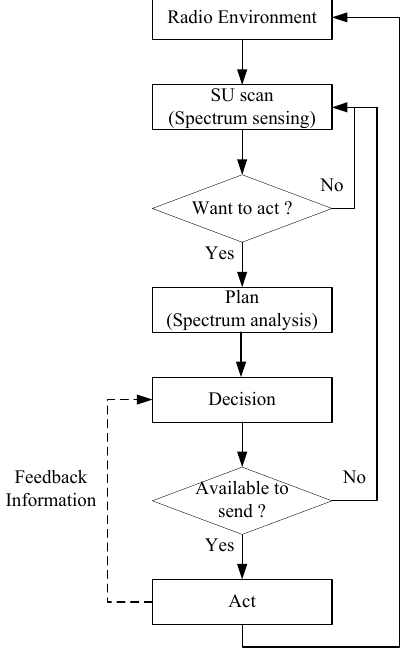
Figure 1. The flow chart of the cognitive radio technology.